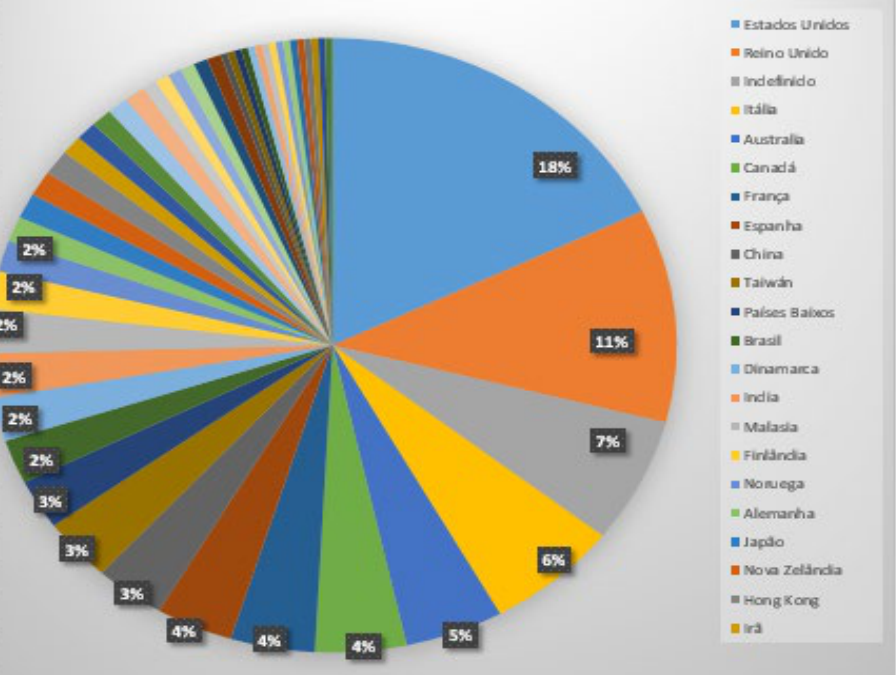
Figure 2. Distribution of research by